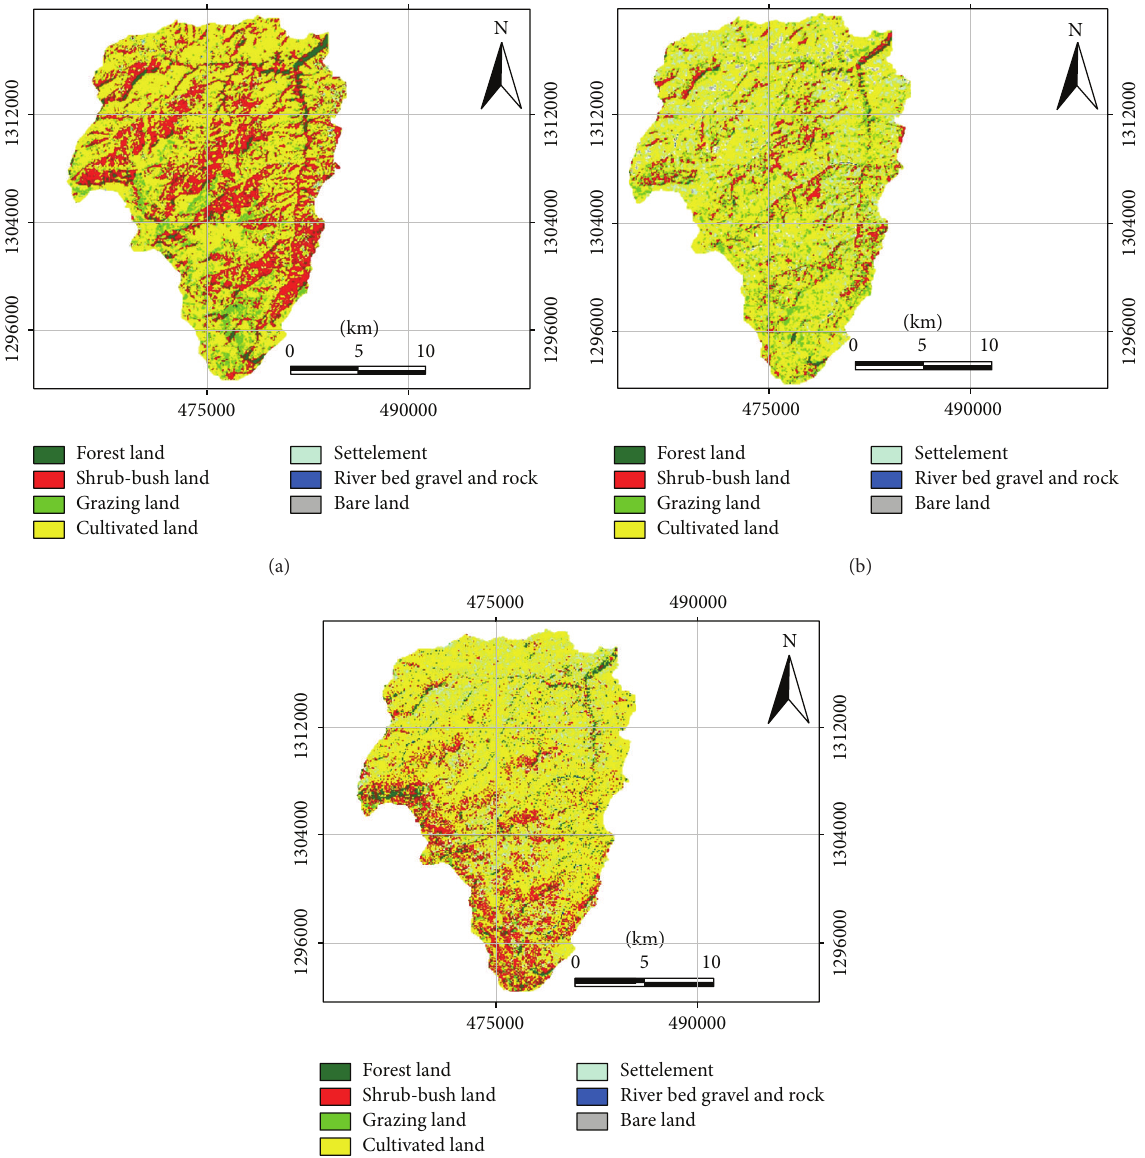
of natural vegetation on degraded lands protected from the intrusion of humans or